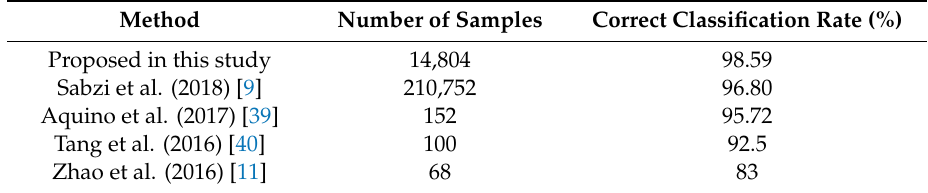
Table 8. Comparison of the accuracy of the segmentation algorithms reported in di ff erent